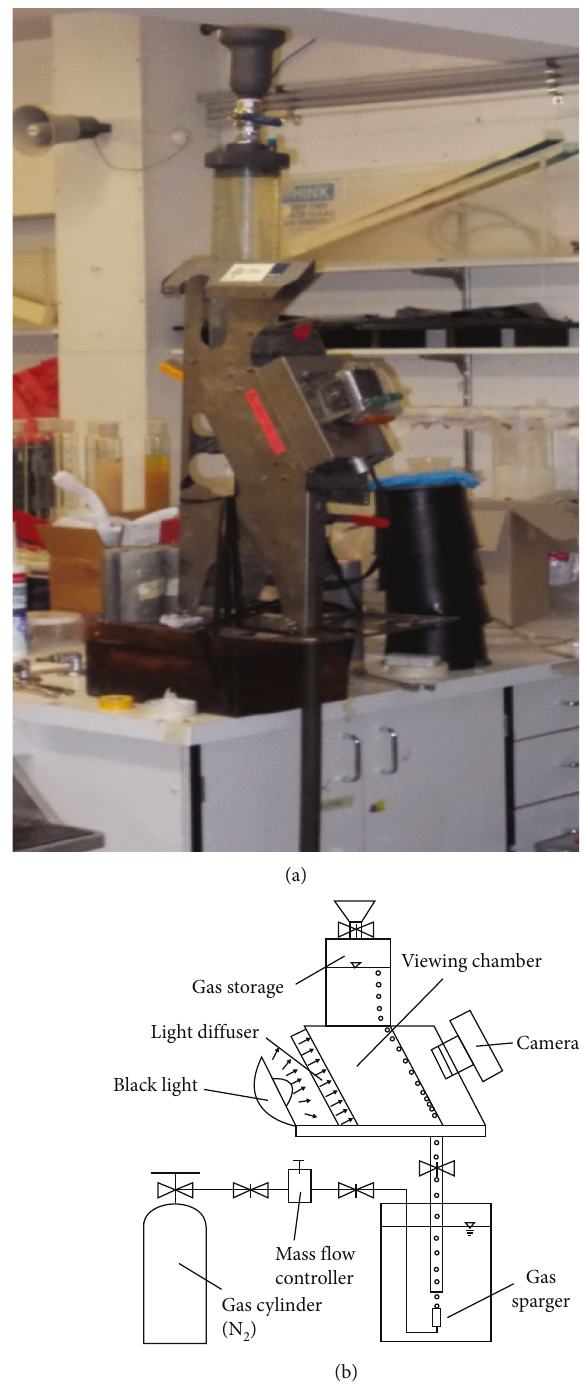
Figure 1: The experimental setup of bubble size measurement in various water solutions: (a) the side view of Anglo Platinum Bubble Sizer and (b) an illustration of the testing system with bubble